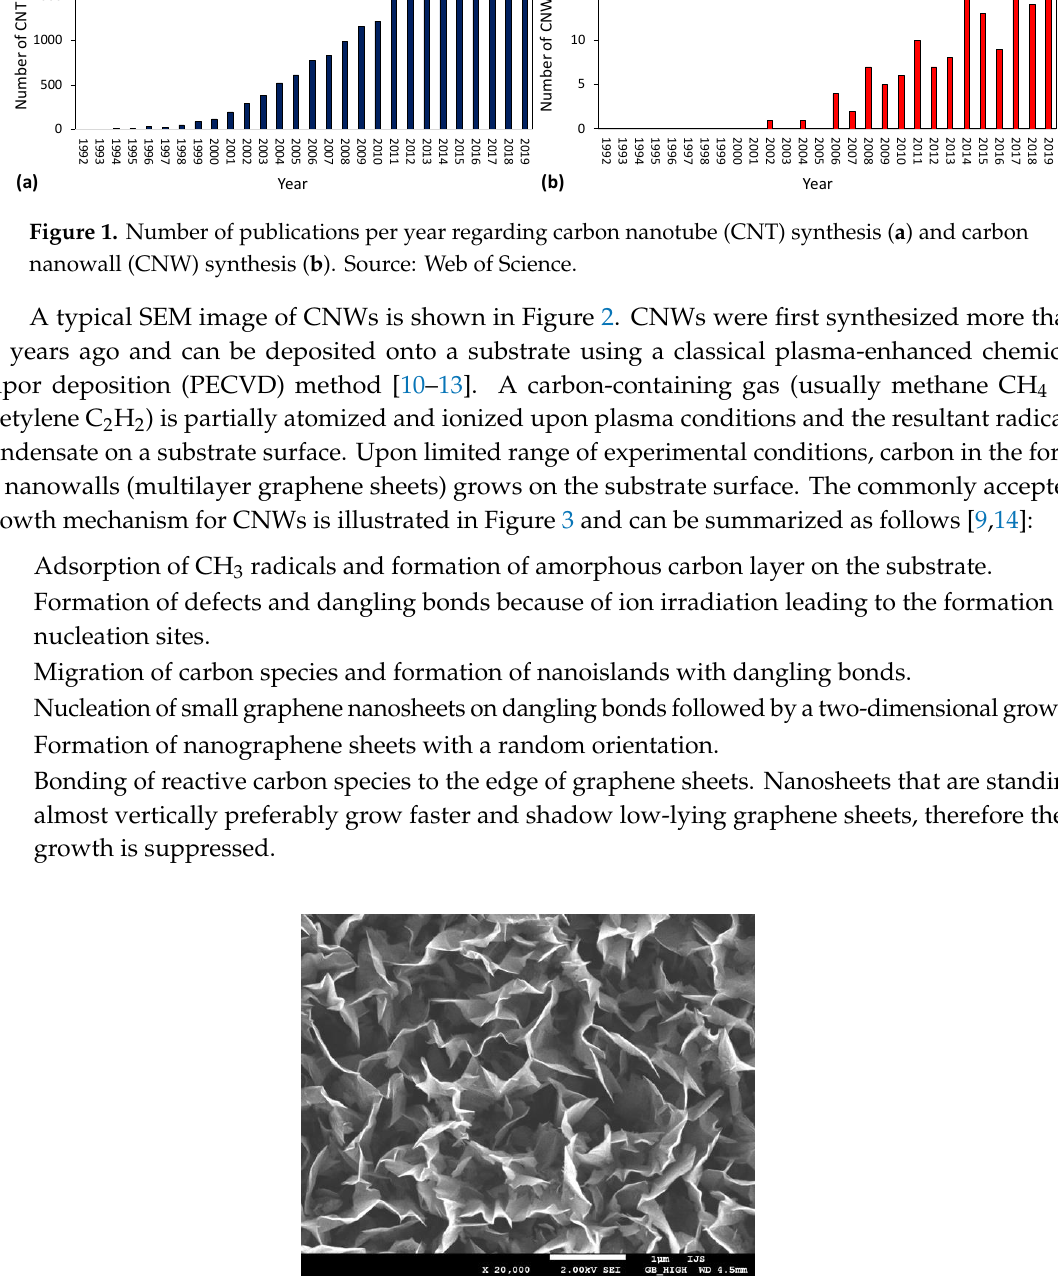
Figure 2. An example of carbon nanowalls grown on the surface of a titanium foil.